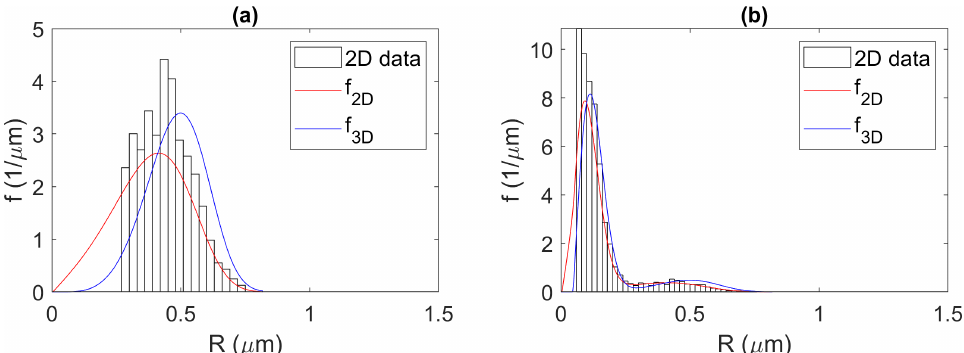
Figure 7. ( a ) The comparison of the measured and calibrated probability size distribution functions, showing the 2D data, 2D prediction, and approximated 3D size distribution considering only the primary particles. ( b ) The comparison of the measured and calibrated probability size distribution functions for both primary and secondary